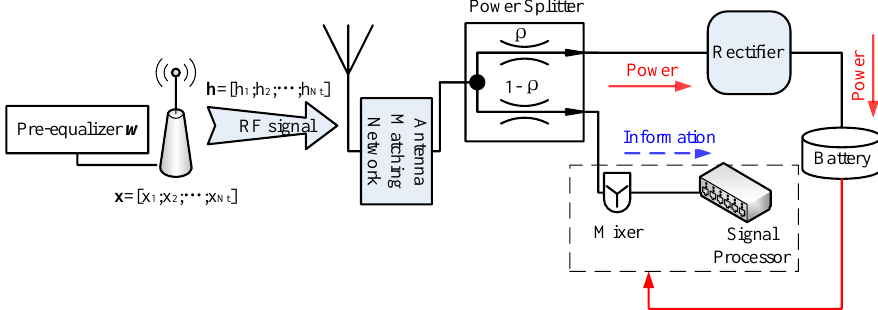
Figure 1. Multisine based simultaneous wireless information and power transfer (SWIPT) system